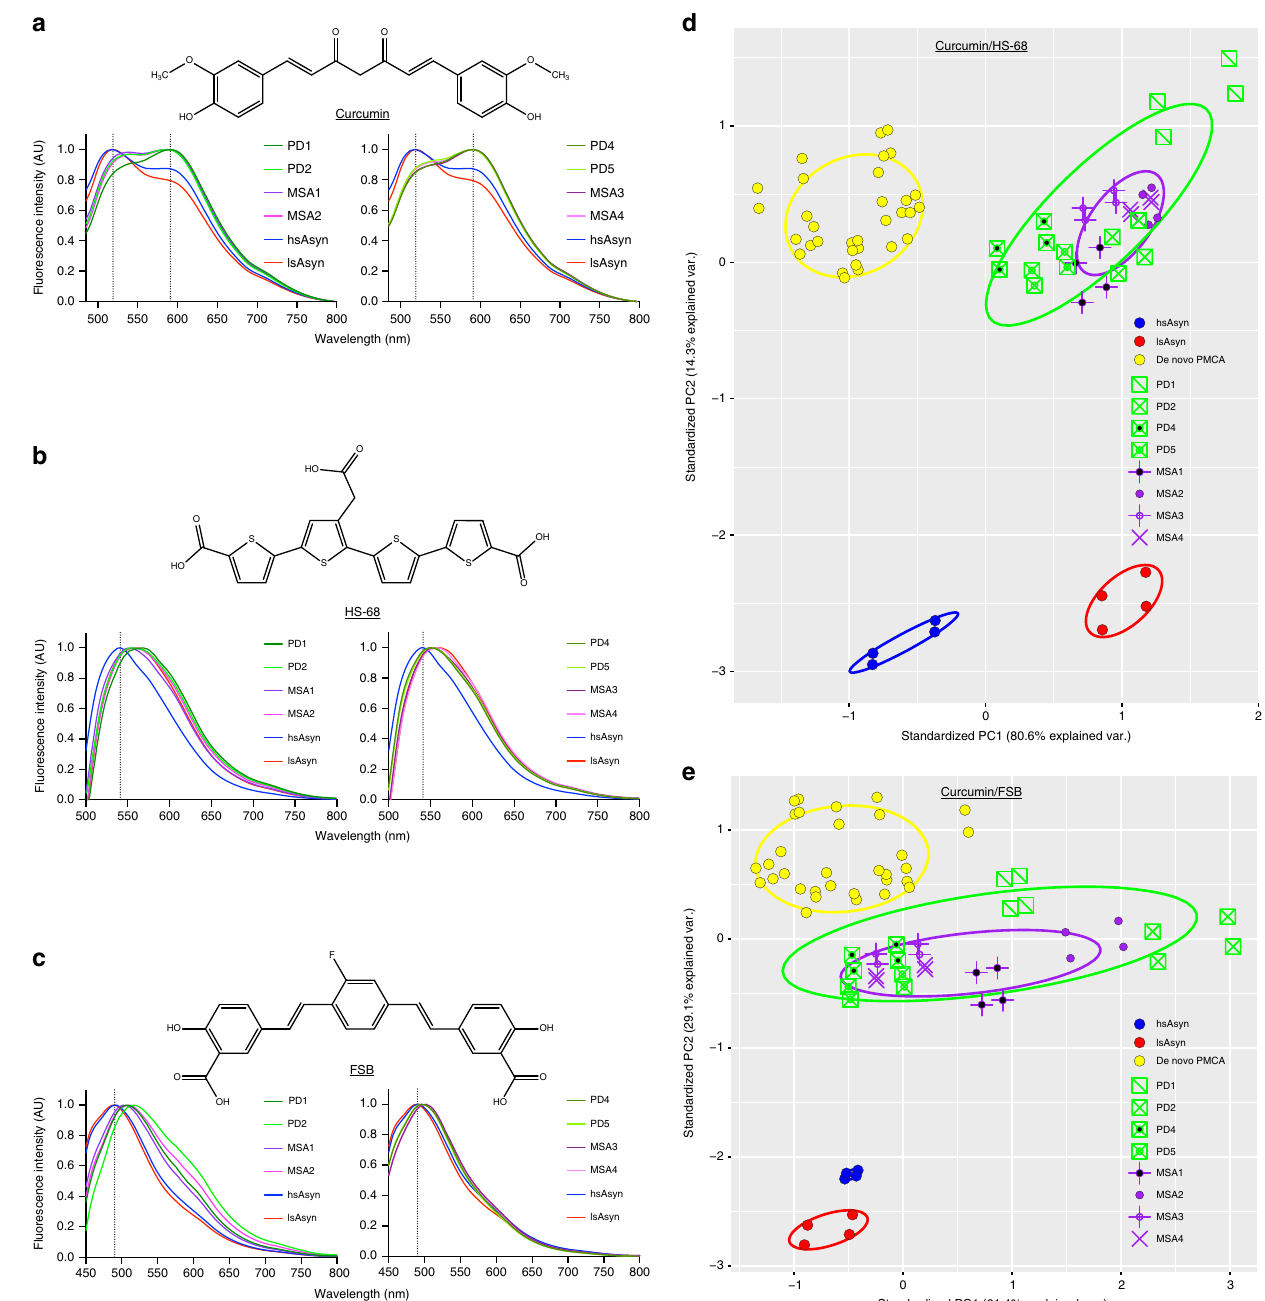
3 Standardized PC1 (61.4% explained var.) Fig. 3 Fluorescent dyes distinguish aSyn aggregate structures. a – c Normalized fl uorescence spectra of curcumin ( a ), HS-68 ( b ) and FSB ( c ) in the presence of amyloid fi brils ampli fi ed from brain extracts of different patients (Table 1; PD/green, MSA/purple), as well as two in vitro aSyn polymorphs (hsAsyn/blue, lsAsyn/red) 5,6 . d , e PCA of fl uorescence spectra of the amyloid-binding dyes curcumin and HS-68 ( d ), and curcumin and FSB ( e ), in presence of aSyn fi brils. aSyn fi brils ampli fi ed from patient brain-extracts are identi fi ed according to Table 1. In addition to brain-extract ampli fi ed fi brils, the fl uorescence spectra of various in vitro polymorphs were analyzed: hsAsyn (blue), lsAsyn (red), and amyloid fi brils formed through de novo aggregation under conditions of PMCA (termed de novo PMCA; yellow). For each sample, fl uorescence spectra of the three dyes were measured independently twice, and the resulting values were joined combinatorially resulting in four data points per sample in order to represent the intrinsic variability in the fl uorescence